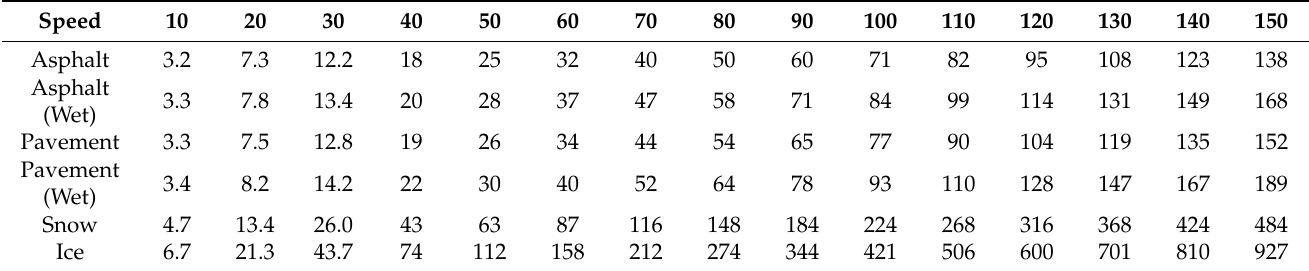
Table 3. Total stopping distance for different road types and for different speeds.